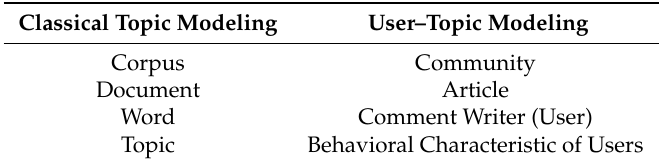
Table 2. Analogies used in user–topic